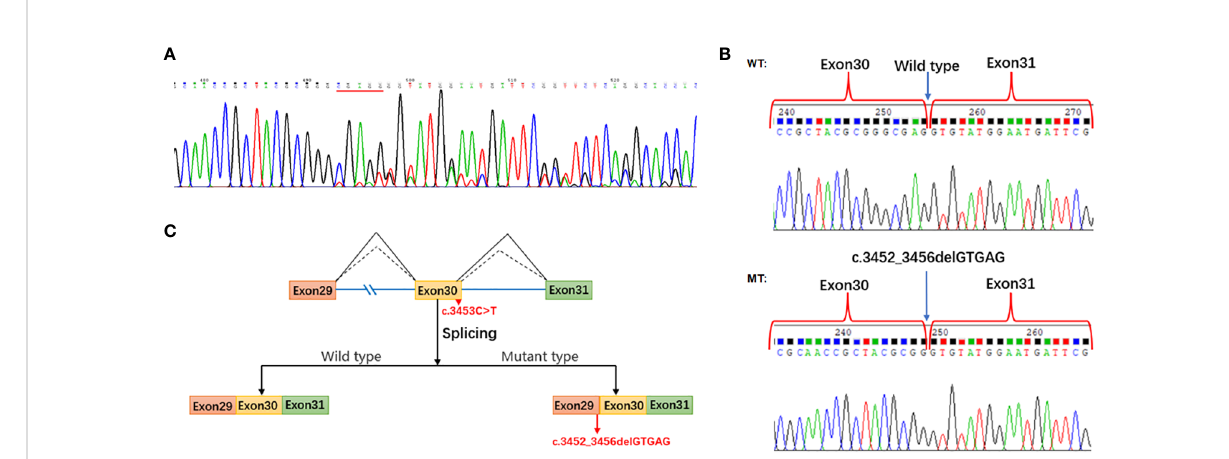
FIGURE 6 Splicing study of PI4KA c.3453C>T. (A) Sanger sequencing of RT-PCR for the proband peripheral blood mononuclear cells. (B) Splicing study by minigene assay; the wild-type fragment is 441 bp and the mutation type 436 bp; Sanger sequencing of RT-PCR for the plasmid expression. (C) Schematic of splicing for PI4KA c.3453C>T. WT, wild type; MT, mutation